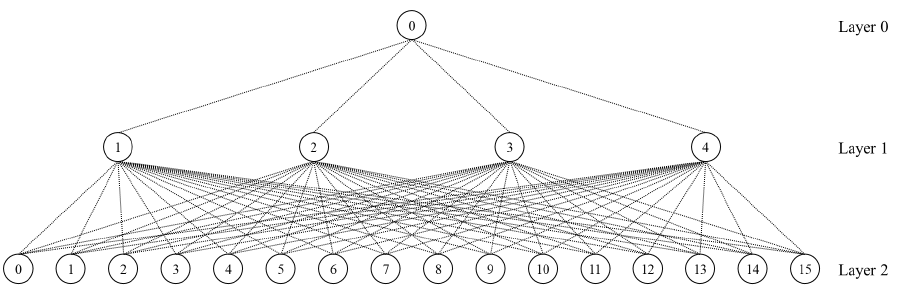
Figure 1. The hierarchical structure of the proposed algorithm when k =